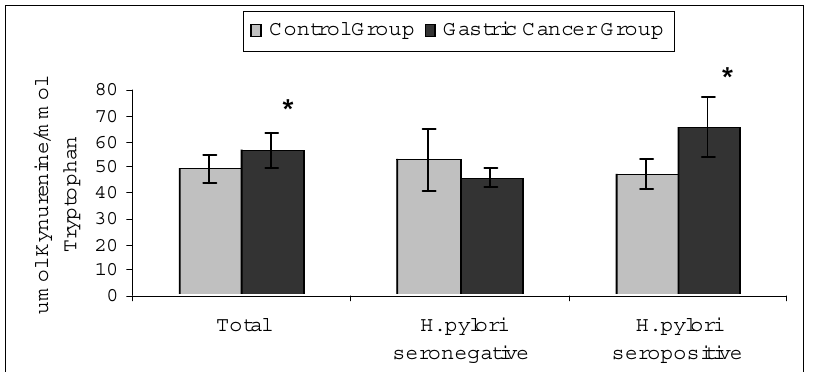
Figure 1. Comparison between kynurenine / tryptophan ratios of gastric cancer patients and of controls without malignant disease, Helicobacter pylori seronegative or seropositive subgroups. *p < 0.05; statistically significant, gastric cancer patients vs. controls, H. pylori seropositive gastric cancer patients vs. H. pylori seropositive